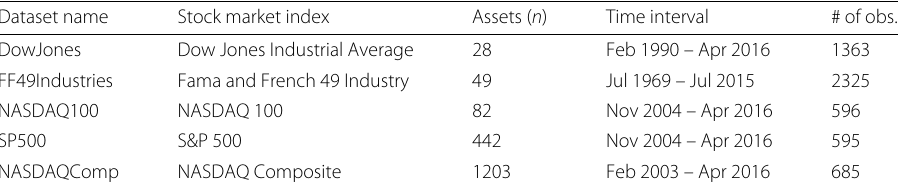
Table 2 Datasets of weekly returns considered in this study (Bruni et al. 2016)